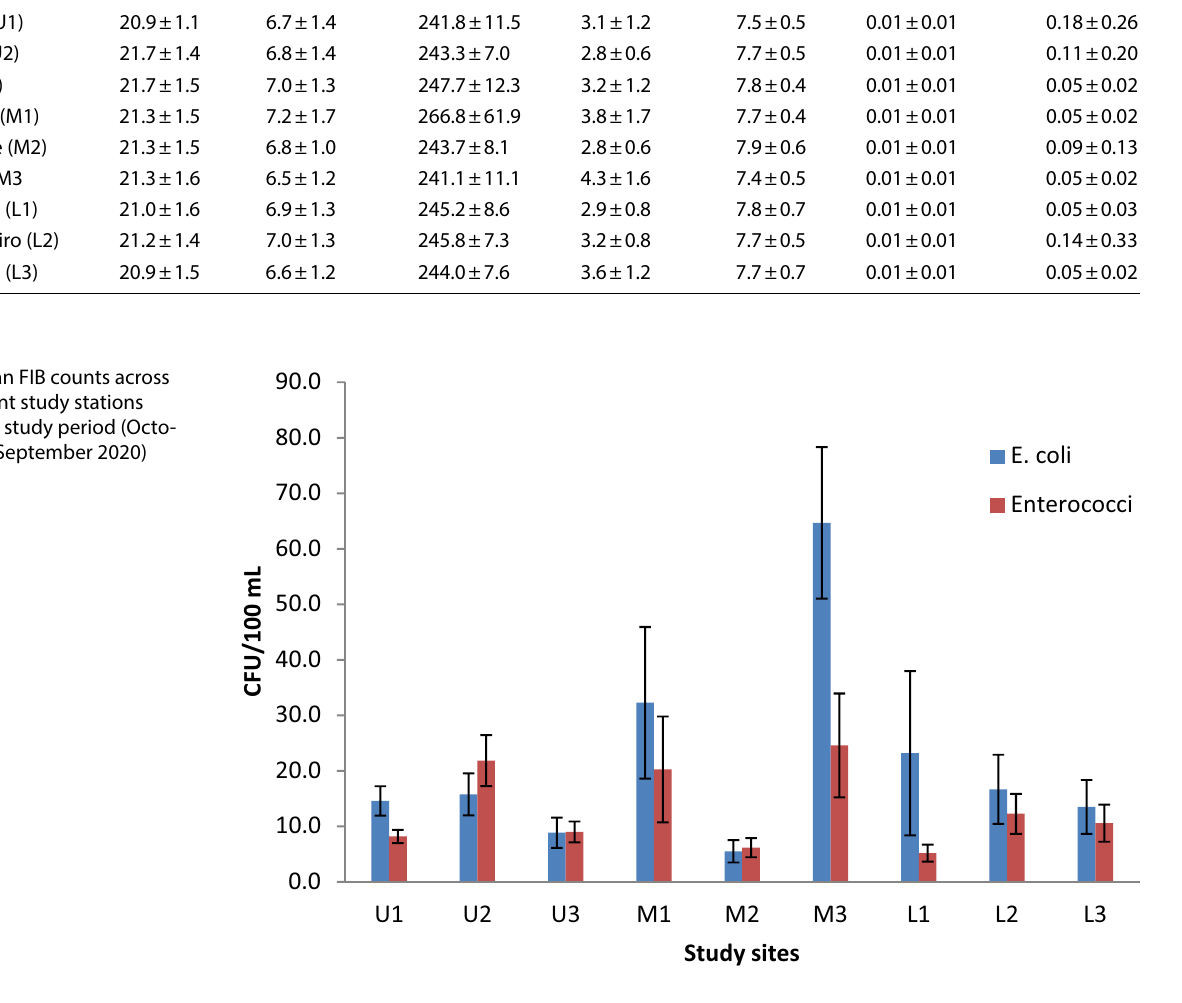
Table 2 Physicochemical parameters variation at different sampling stations. Mean values ± standard deviation obtained from different months (n = 12) Station Temp ( o C)